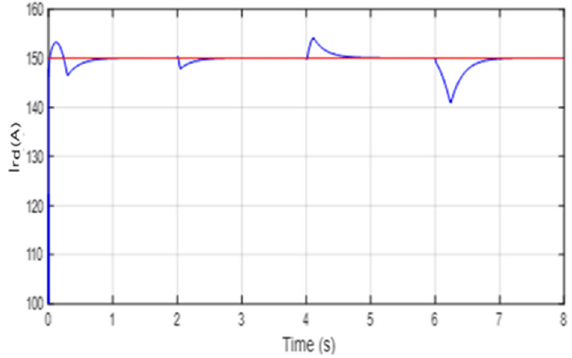
Fig. 11 Aerodynamic torque estimation